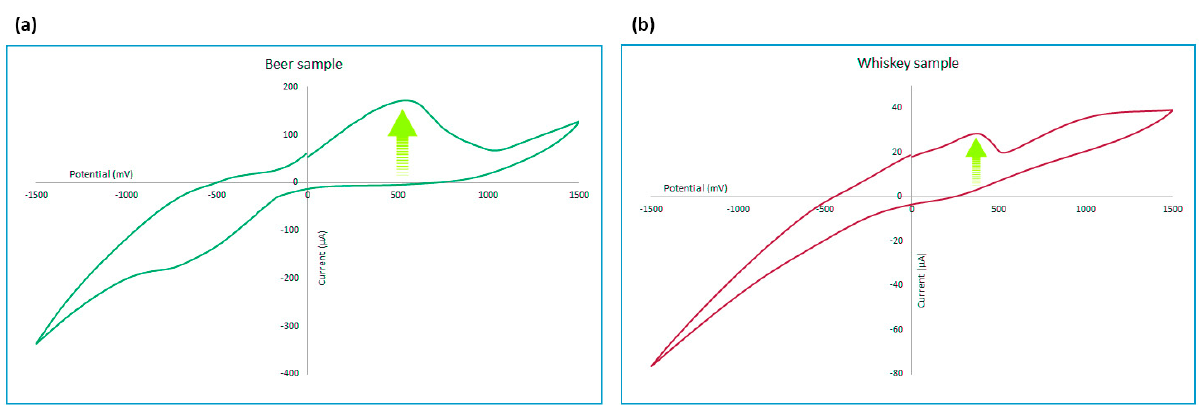
Figure 11. Response of the graphene–indium oxide sensor to ( a ) beer and ( b ) whisky as authentic samples.